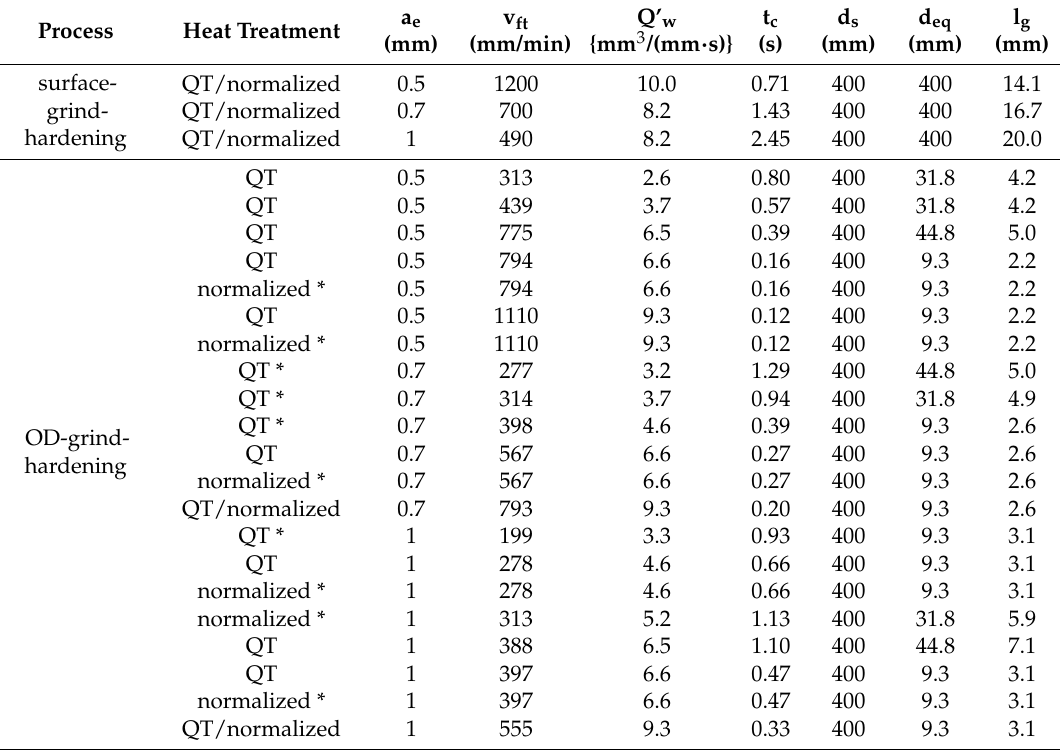
Table 1. The heat treatment and process parameters for grind-hardening